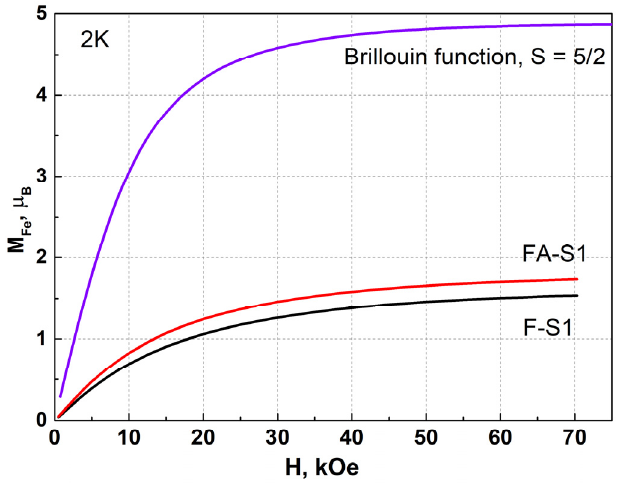
Figure 6. Magnetization curves of F-S1-1 and FA-S1-3 samples at 2 K.